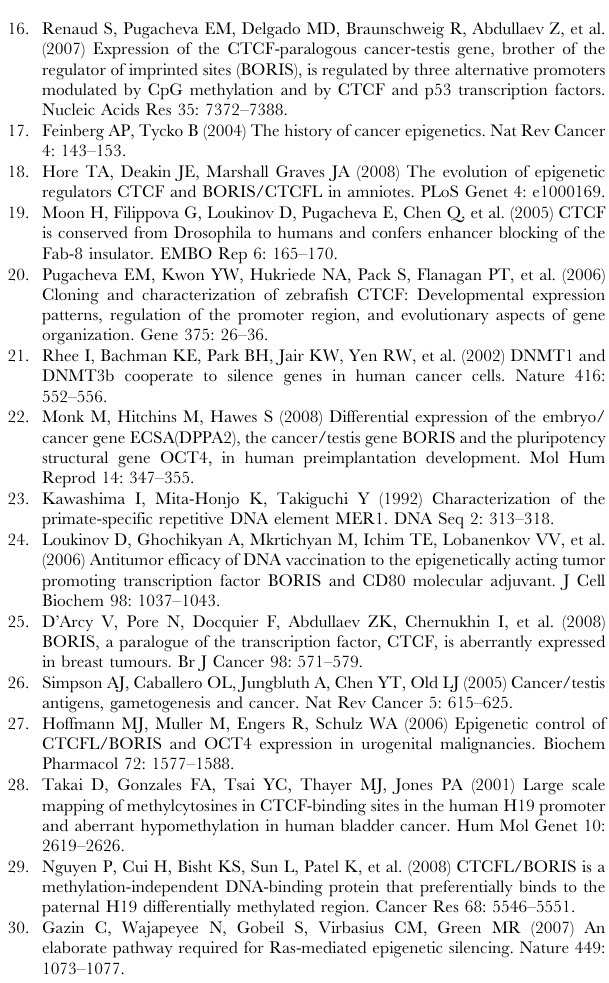
Table S3 The 23 alternatively spliced BORIS mRNAs are predicted 17 isoproteins. Table 3 summarizes the information about BORIS alternative forms, including the size of alternative transcripts in nucleotides, the size of isoproteins in kDA, the calculated isoelectric point of each protein, the number of ZF per isoform, the alternative N- and C-termini and the GenBank accession number for each BORIS isoform.